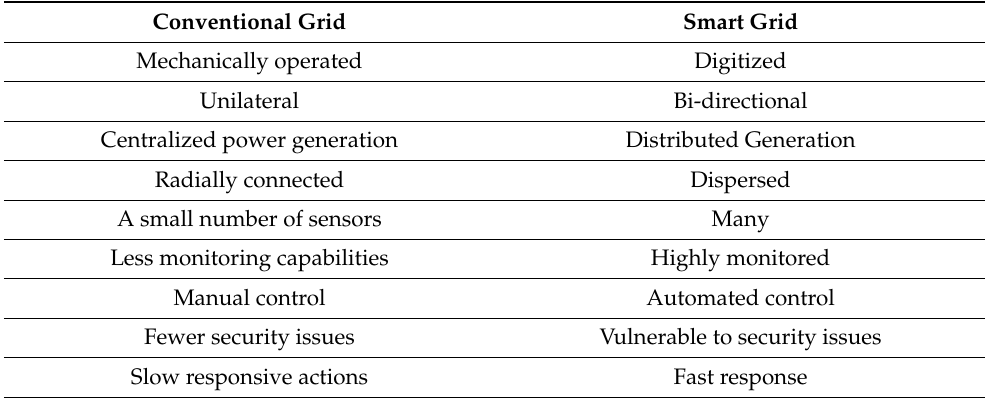
Table 1. Comparative study between Conventional Grid and the Smart Grid